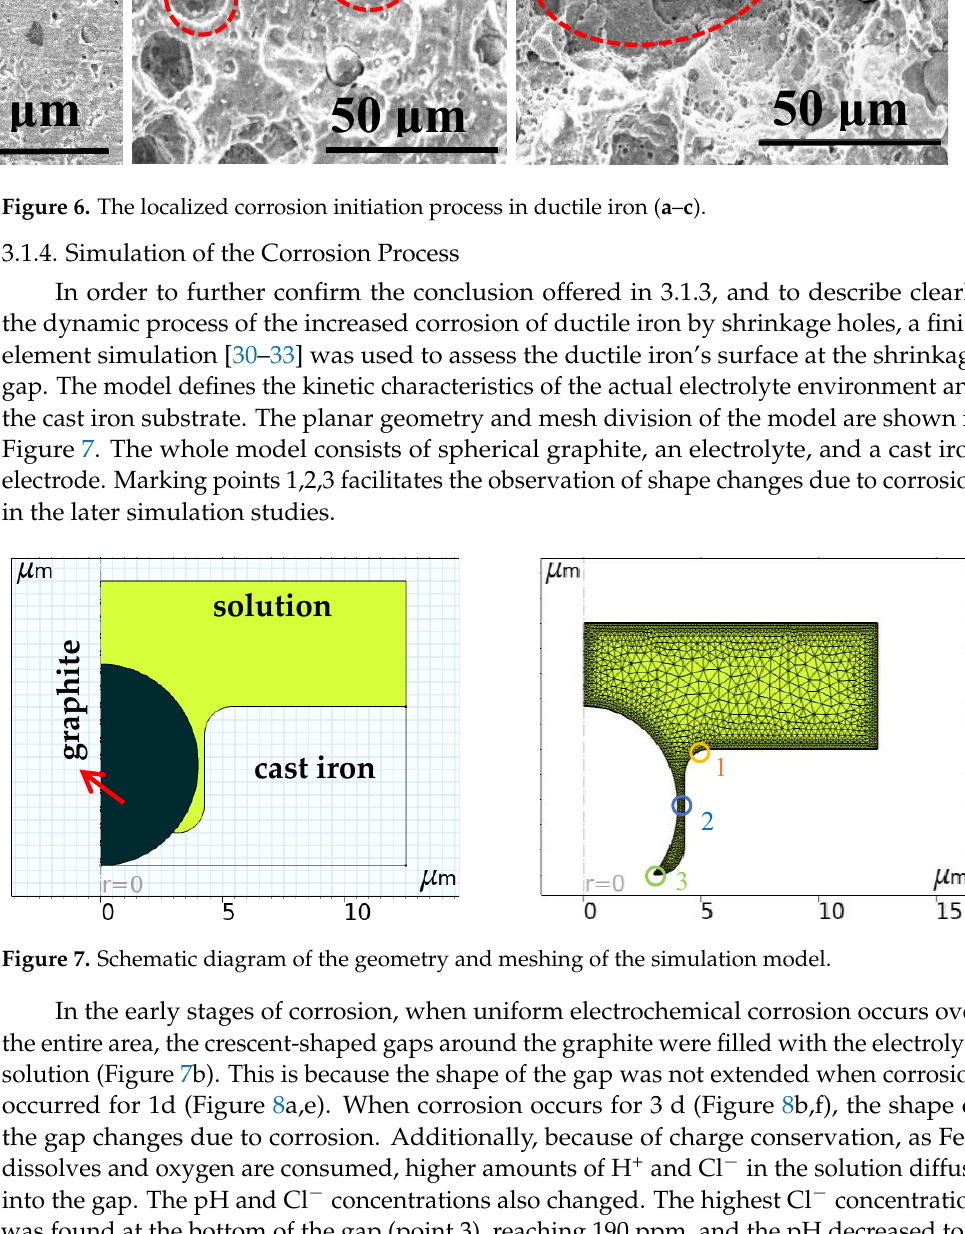
Figure 7. Schematic diagram of the geometry and meshing of the simulation model.